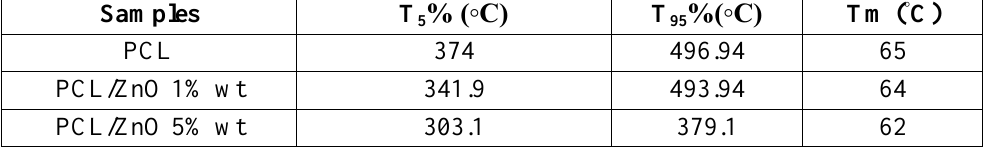
Fig.6: Thermal Gravimetric Analysis of PCL /ZnO nanocomposites at (1%wt and 5% wt). Table 2: Thermal Gravimetric Analysis of puret PCL and PC /ZnO